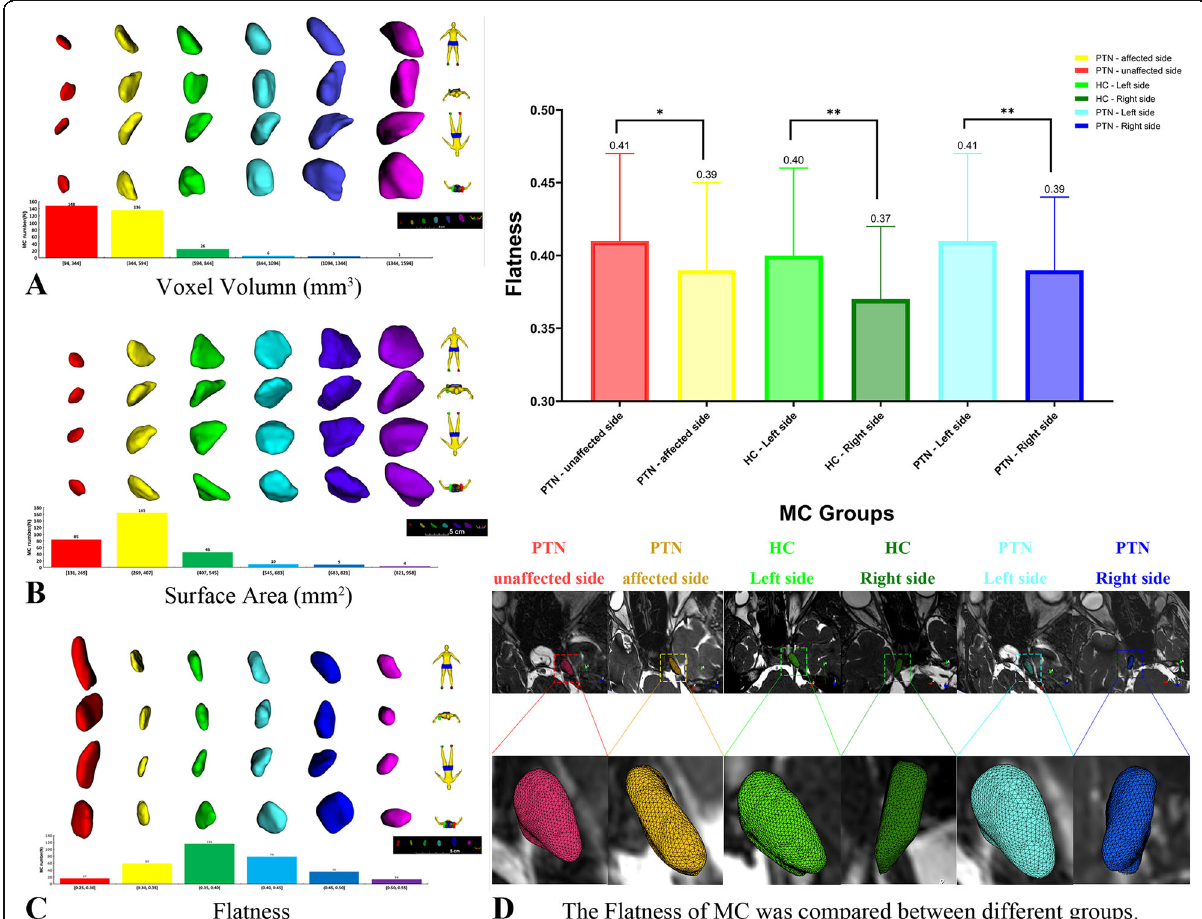
Fig. 2 Morphology of MC with different morphological characteristics. ( A ) The red MC ’ s voxel volume is 94mm 3 , the yellow is 347mm 3 , the green is 601mm 3 , the light blue is 904mm 3 , the navy blue is 1136mm 3 and the purple is 1589mm 3 .( B ) The red MC ’ s surface area is 131mm 2 , the yellow is 335mm 2 , the green is 482mm 2 , the light blue is 569mm 2 , the navy blue is 784mm 2 and the purple is 853mm 2 . ( C ) The red MC ’ s flatness is 0.25, the yellow is 0.32, the green is 0.37, the light blue is 0.42, the navy blue is 0.47 and the purple is 0.54.( D ) The flatness of MC was compared between different groups.** P < 0.01; * P <